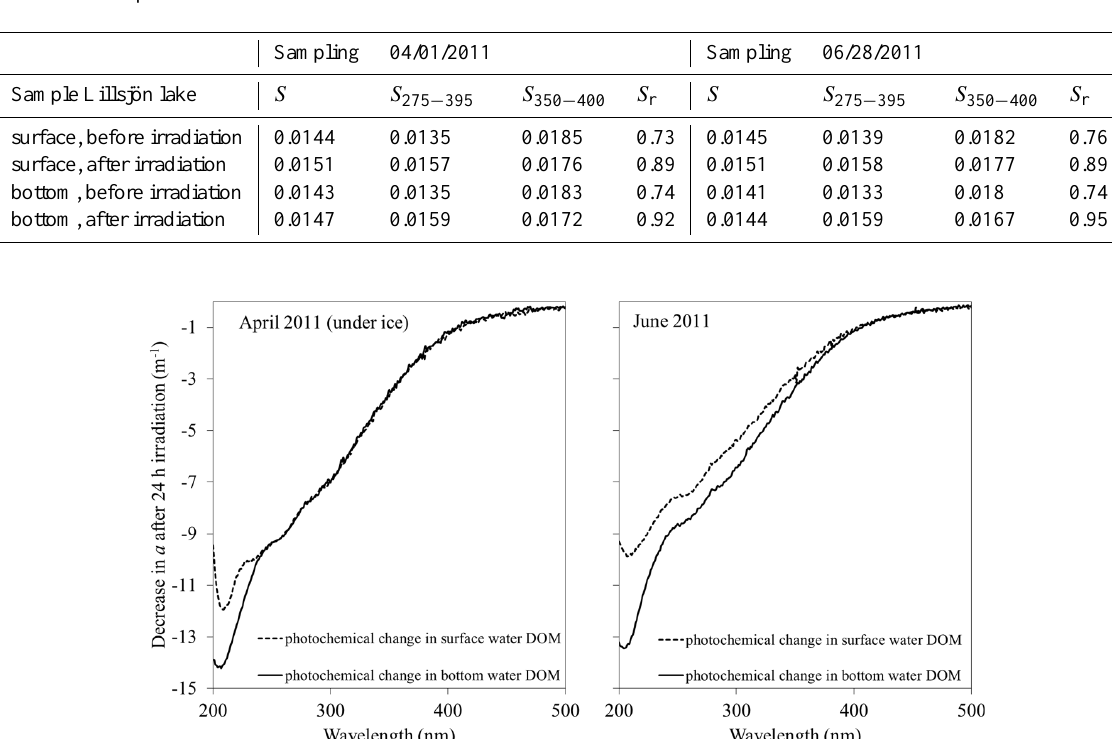
Table 2. UV-Vis spectral slopes at distinct wavelength ranges and the resulting spectral slope ratios ( S r ) of surface and deep boreal lake water samples collected in April and June 2011.